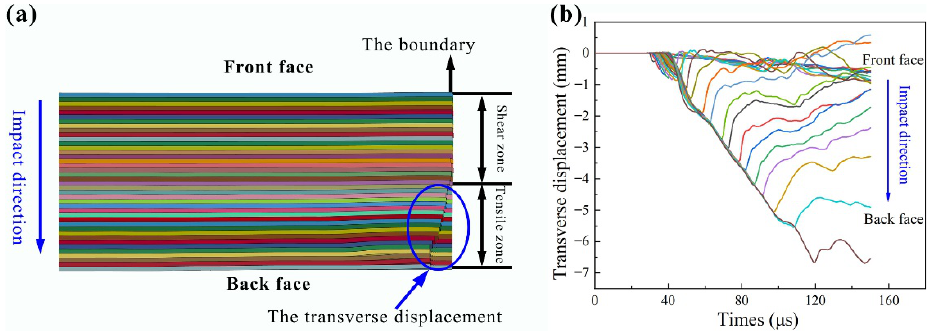
Figure 8. The transverse displacement of the laminate in simulations: ( a ) the shear and tensile zone, ( b ) the transverse displacement history curves of each layer.